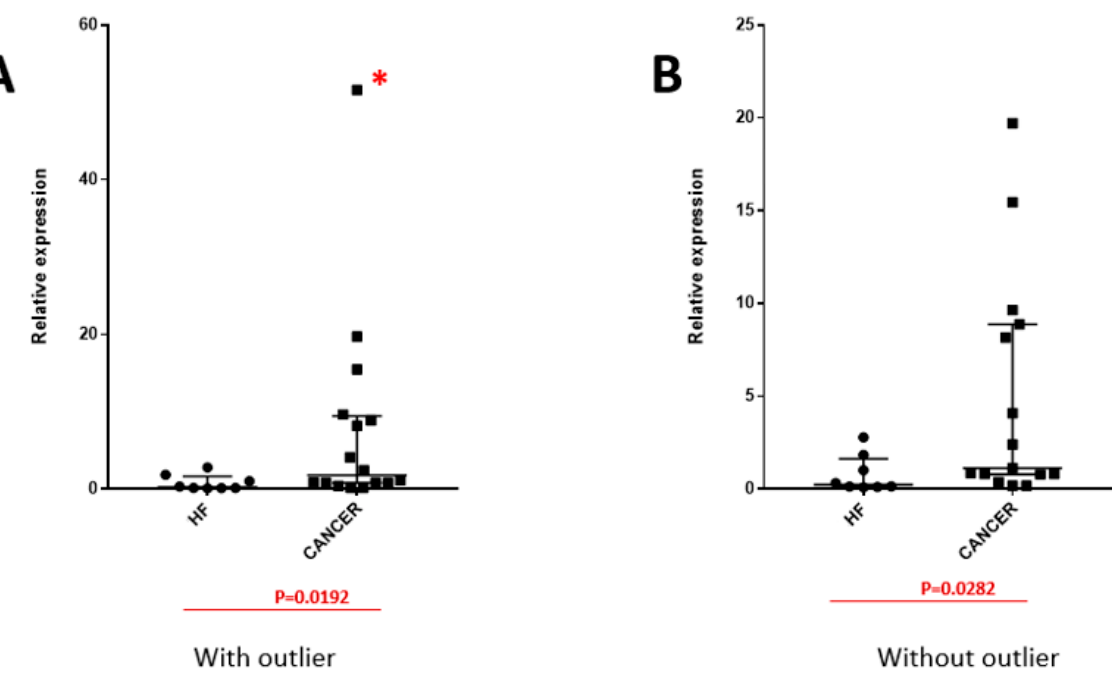
Figure A1. miR-1246 expression between cancer and non-cancer heart failure (HF)-induced pleural effusion with the presence of an extreme value of miR-1246, considered as a potential outlier (identified with a red *), as demonstrated in image ( A ) and after the exclusion of outlier value, as demonstrated in image ( B ).